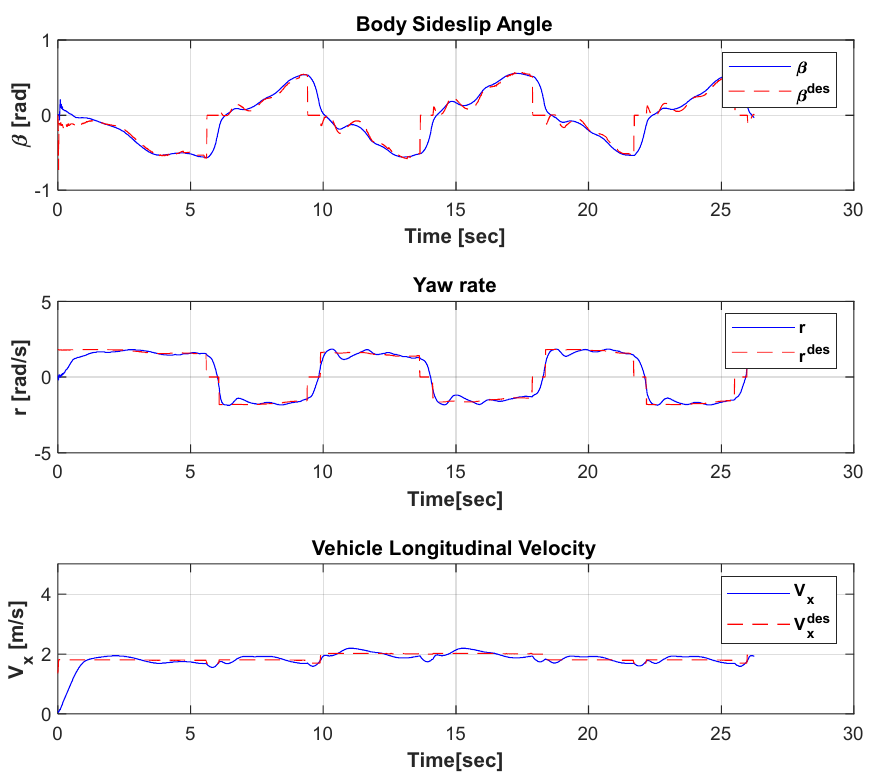
Figure 18. Vehicle states during a drift maneuver (solid blue lines). The desired equilibrium points (dotted red lines) are plotted for reference.